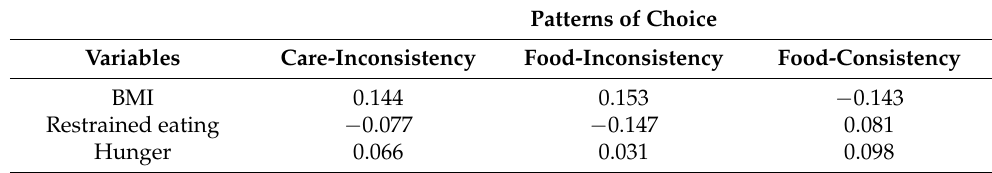
Table 1. Correlation matrix of factors that may covary with patterns involving food pictures.